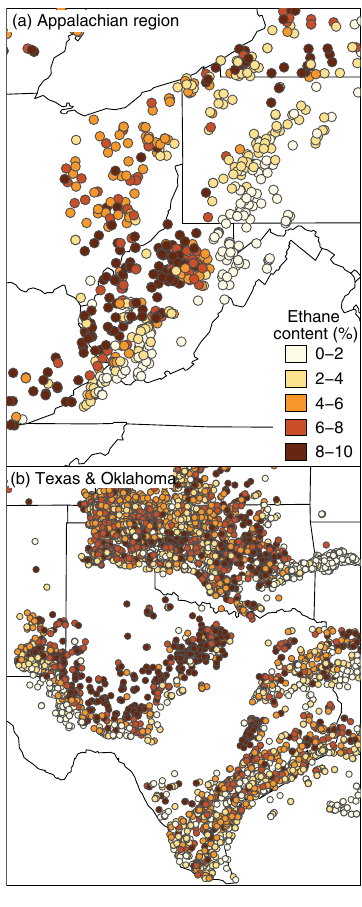
Figure 3. This figure shows the variability in ethane content of nat- ural gas for two major drilling regions of the US. Ethane content is a key parameter when estimating oil and gas CH 4 emissions using atmospheric ethane measurements. The samples show substantial heterogeneity in some regions (e.g., Oklahoma) and exhibit clear spatial patterns in other regions (e.g., Texas and West